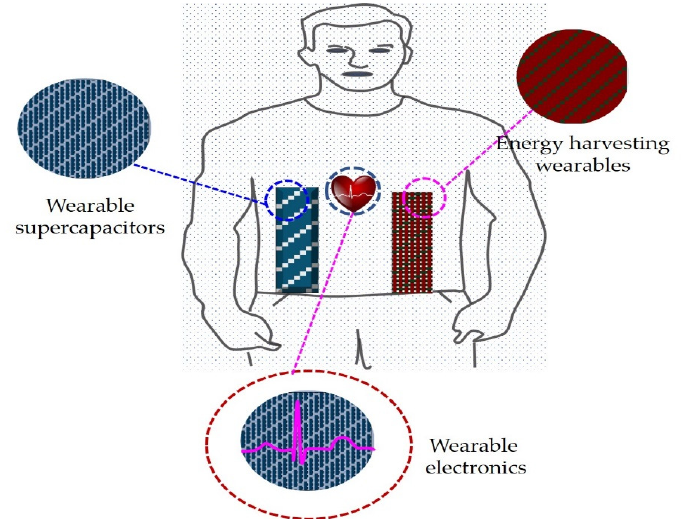
Figure 4. Personal and wearable electronics realized by introducing conductive polymers on wearable fabrics. The fabrication follows easy, simple and uses simple design.